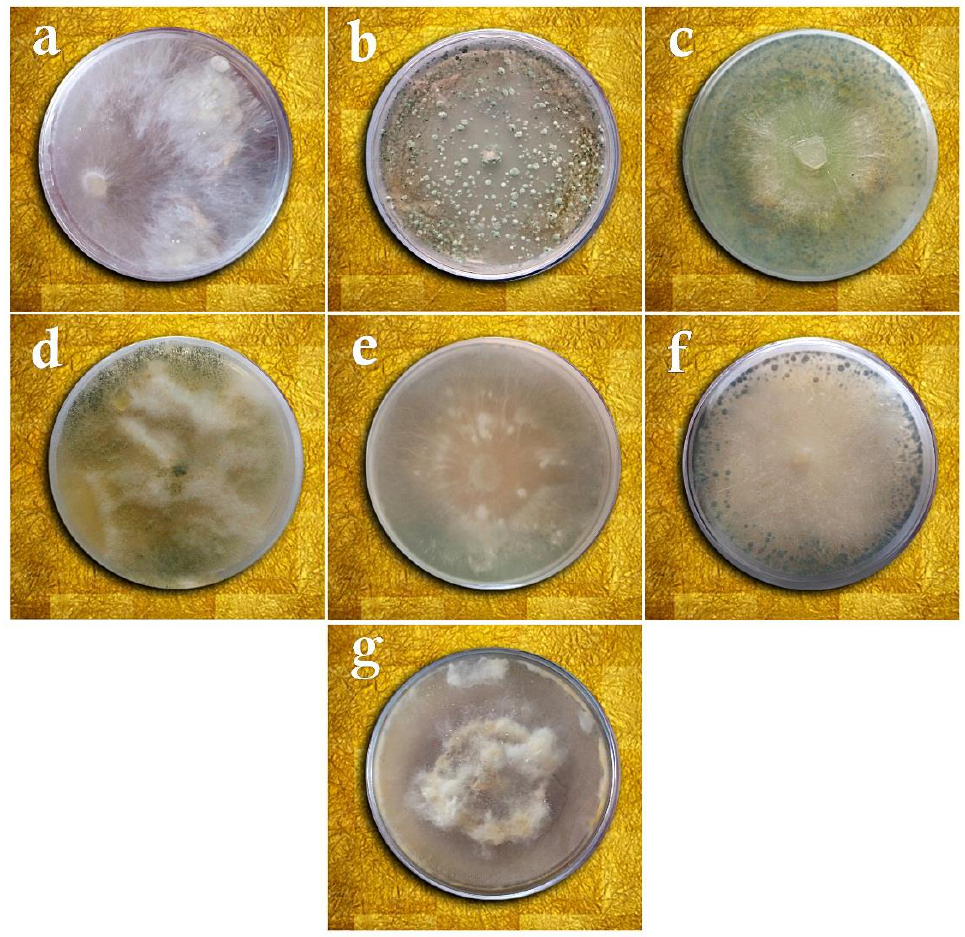
Figure 6. Non-volatile metabolites test of Sclerotium rolfsii versus the studied fungi on the PDA medium: ( a ) Sclerotium rolfsii (control), ( b ) Trichoderma viride , ( c ) Penicillium rubens (MN395854.1), ( d ) Aspergillus flavus , ( e ) Penicillium decaturense , ( f ) Penicillium rubens (MN395851.1), ( g ) Trichoderma virens